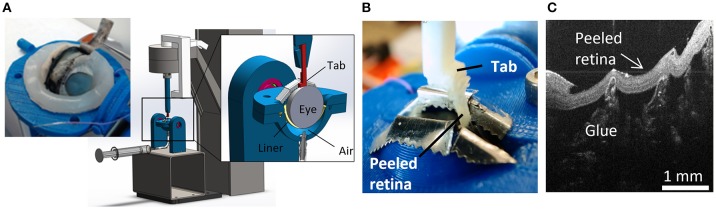
For each peel test, (A) sclera was dissected away from the retina prior to testing, and the eye placed in the fixture. The eye was raised toward the testing window by inflating a polymer liner with air. (B) An L-shaped tab was glued to the retina and raised to peel the retina from the vitreous while measuring force. (C) Optical coherence tomography image of the peeled retina indicating separation was at the vitreoretinal interface and glue penetration was minimal.